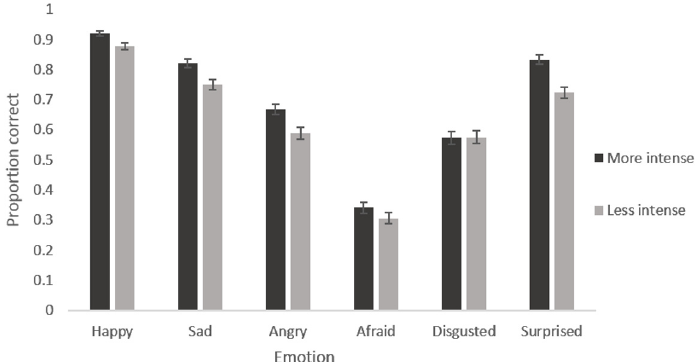
Fig 4. Mean proportion of correct responses to images showing each emotion at each intensity level. Error bars show standard error.